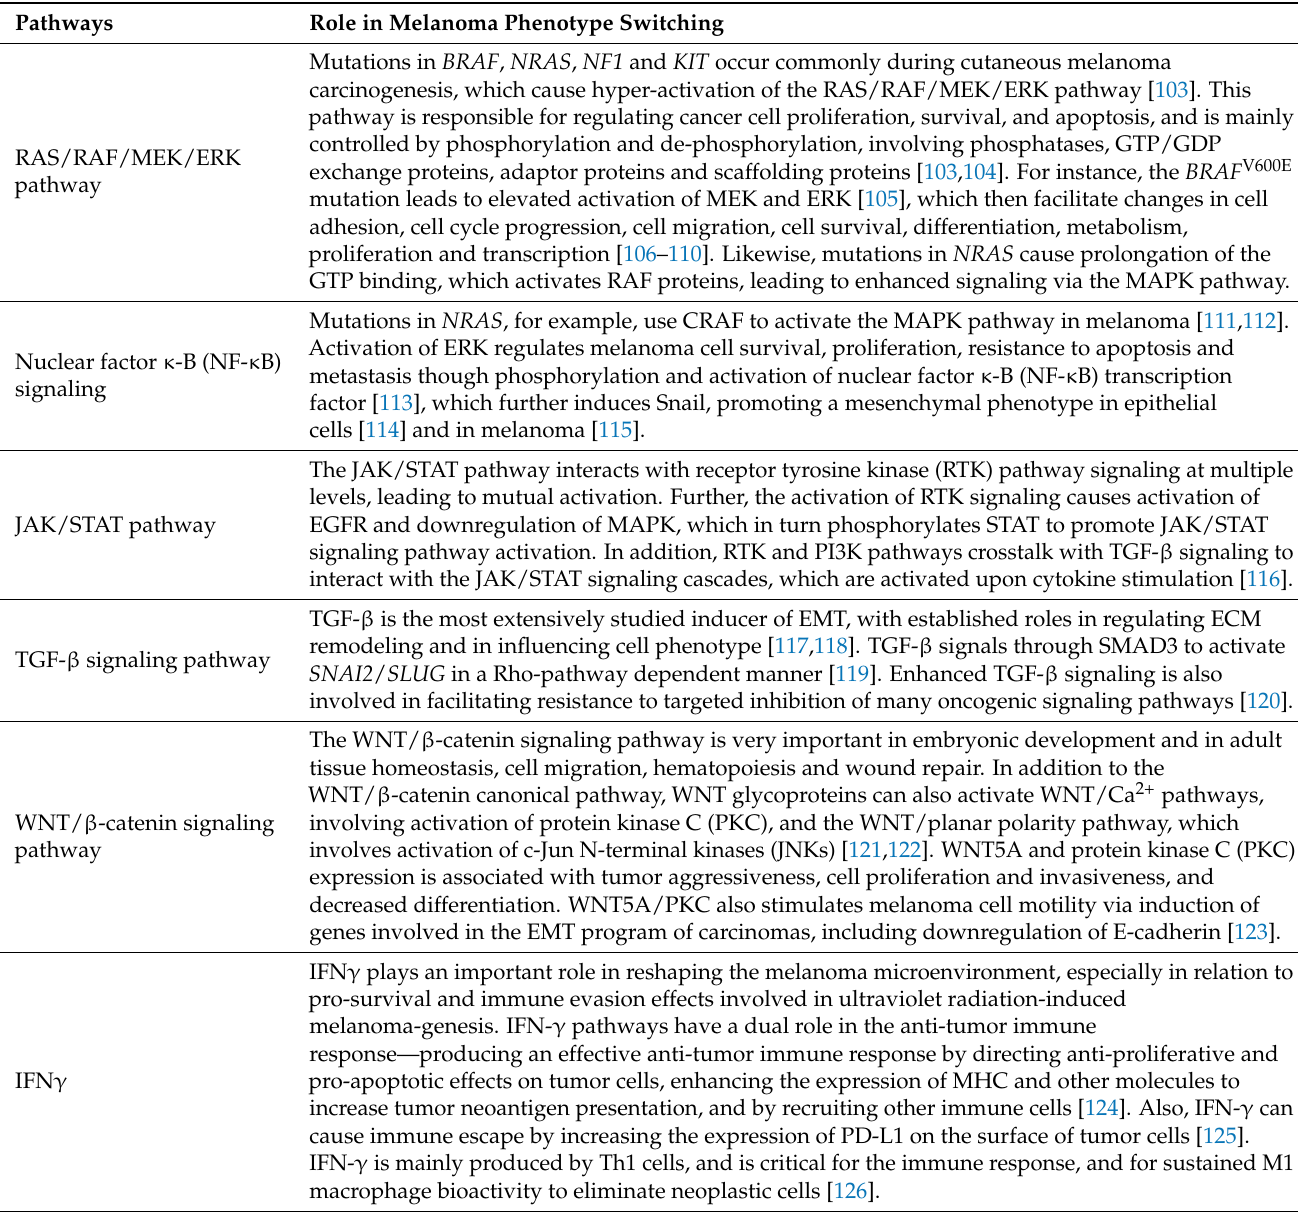
Table 2. Role of signaling pathways in melanoma phenotype